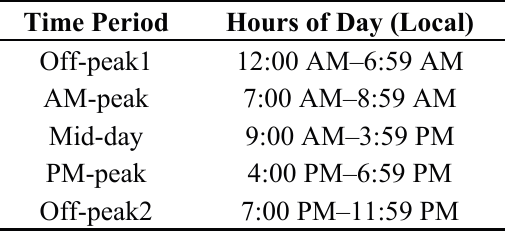
Table 2. Modeled time periods of day for determining speed and estimating exposure.